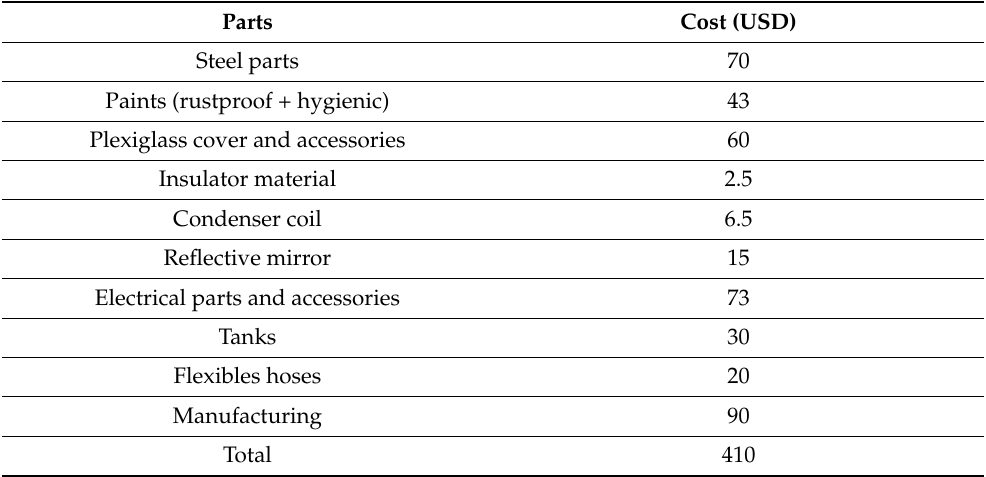
Table 1. Cost evaluation of the solar still prototype.